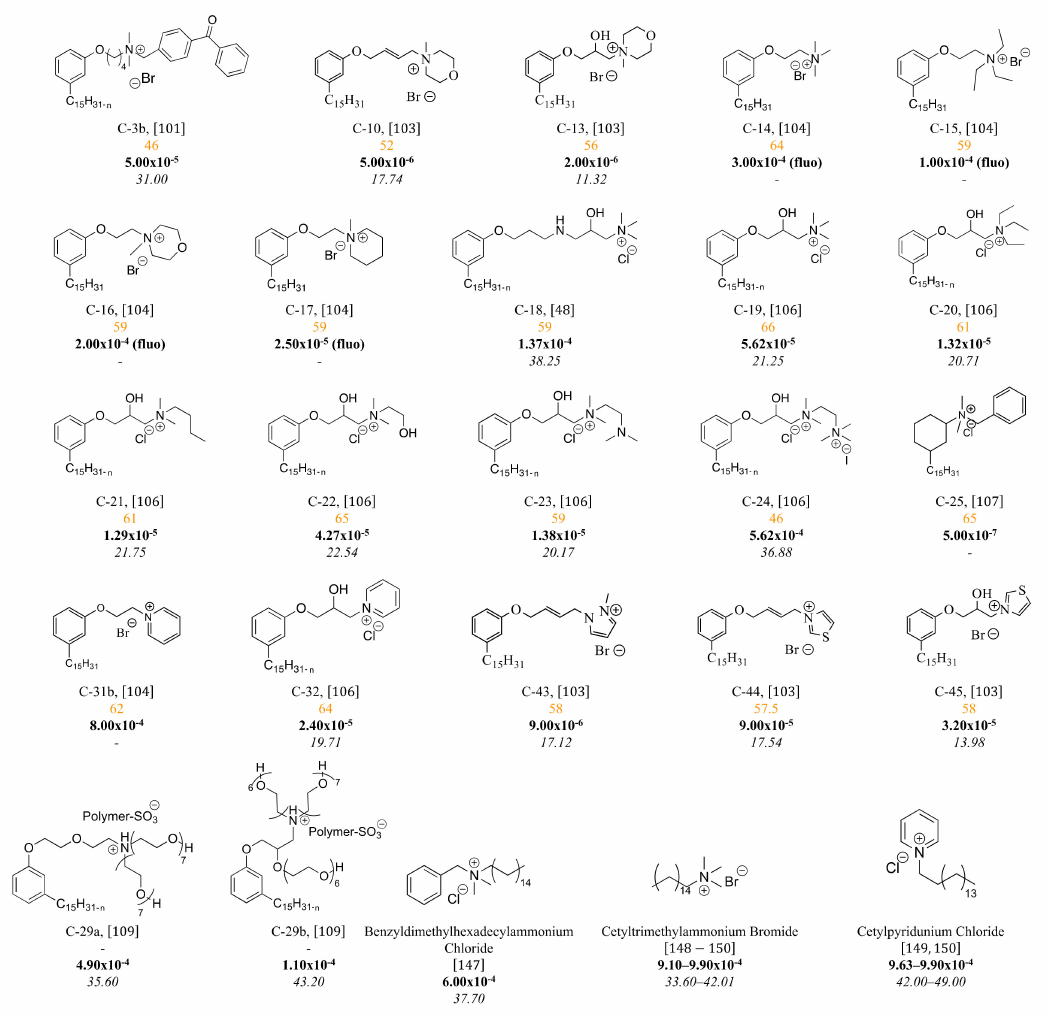
Figure 11. % bio (orange in between (50–75%), CMC (mol/L, bold) and surface tension (mN/m, italics) of cationic CNSL-based surfactants.